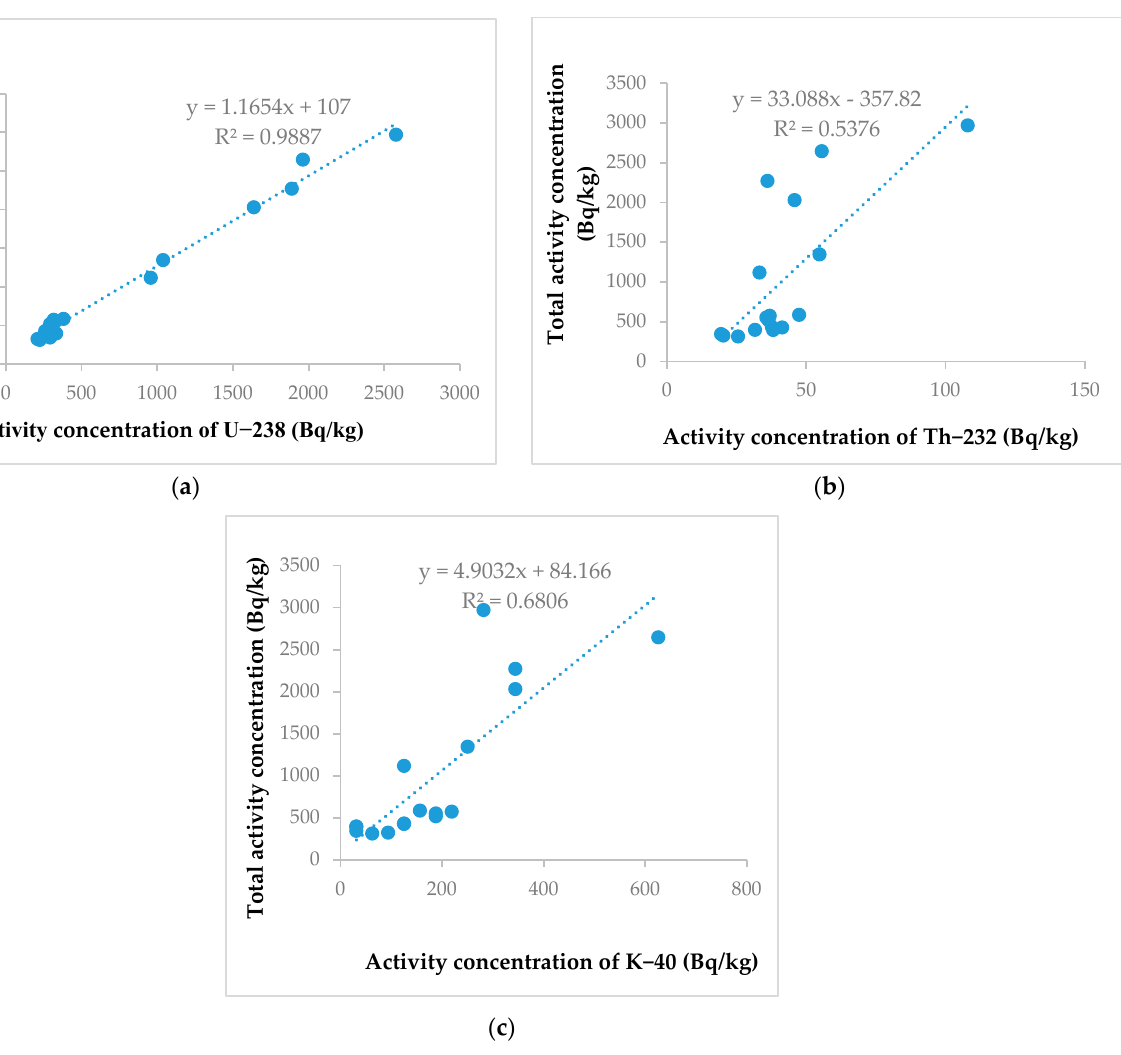
Figure 6. Contribution of each radionuclide to the total activity concentration due to 238 U, 232 Th, and 40 K in the tailings. ( a – c ) presents the contribution of 238 U, 232 Th, and 40 K to the total radioactivity measured, respectively.